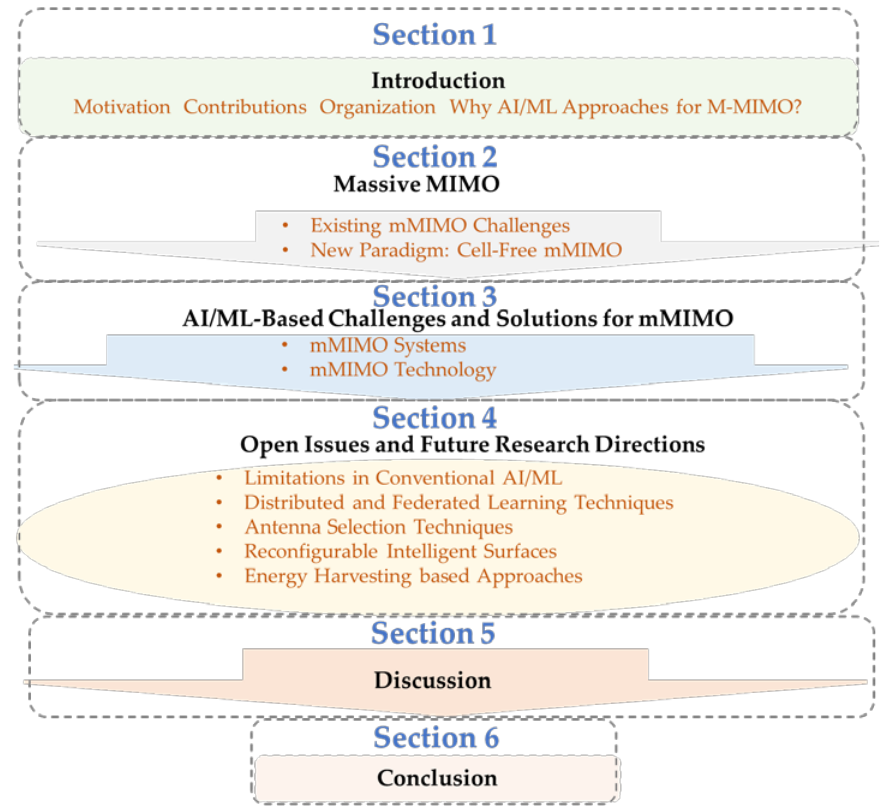
Figure 2. The paper’s structure and organization.